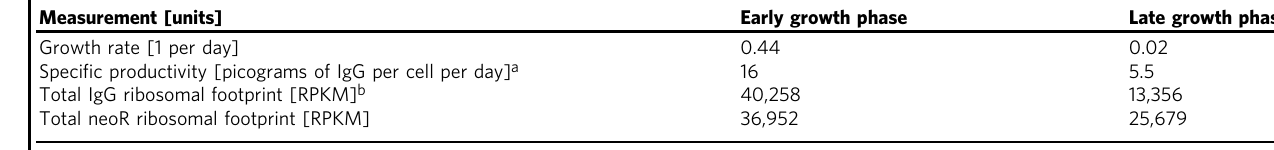
Table 2 Experimental data used for validation of iCHO2048s predictive